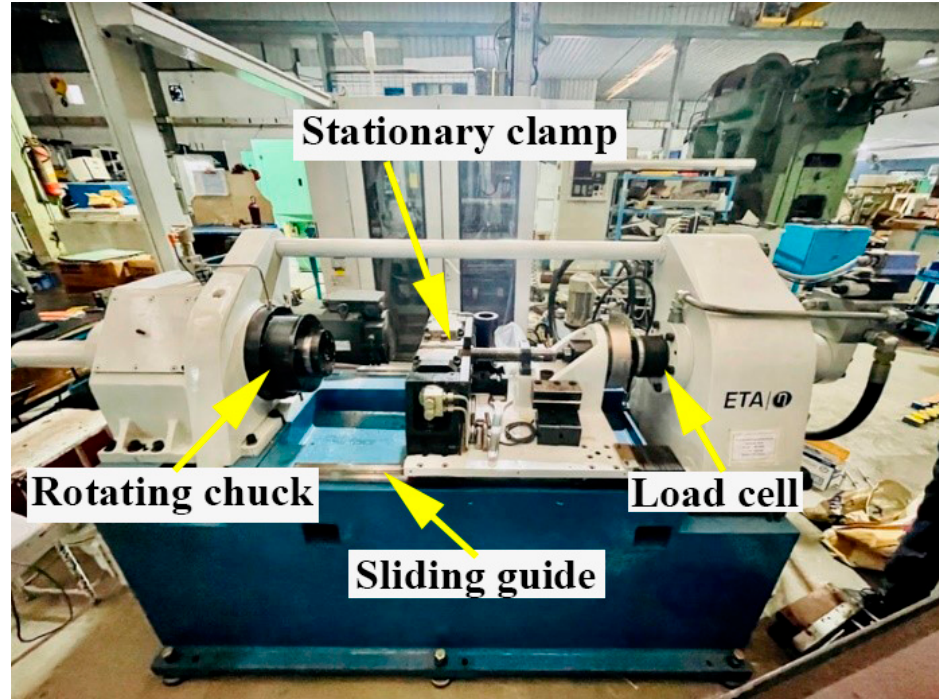
Figure 1. Rotary friction welding setup used to weld-dissimilar AISI 316L/IN 718 combinations .